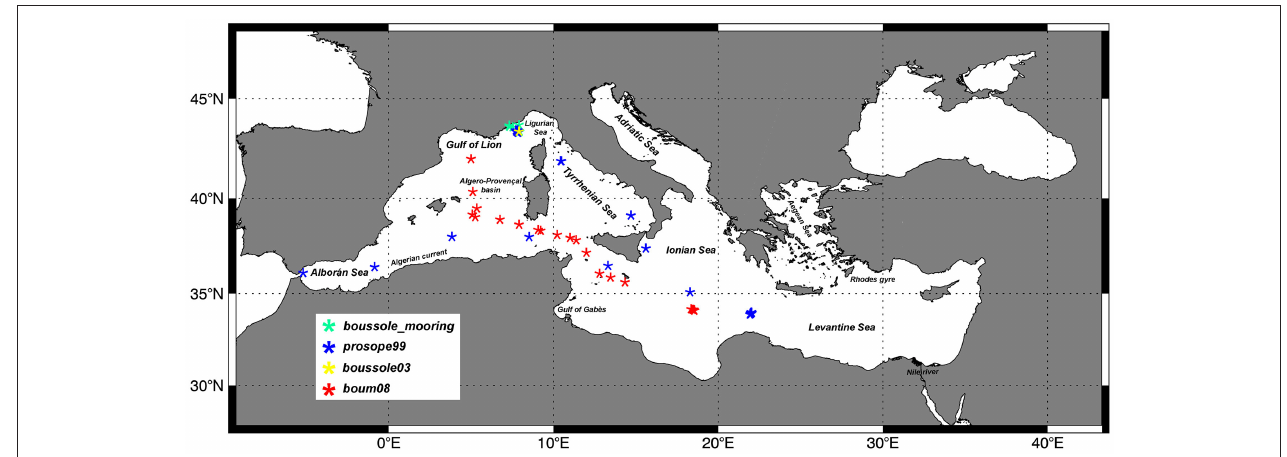
FIGURE 1 | Spatial distribution of the phytoplankton pigments in the SeaBASS Mediterranean HPLC subset (Werdell and Bailey, 2005) used for this work.